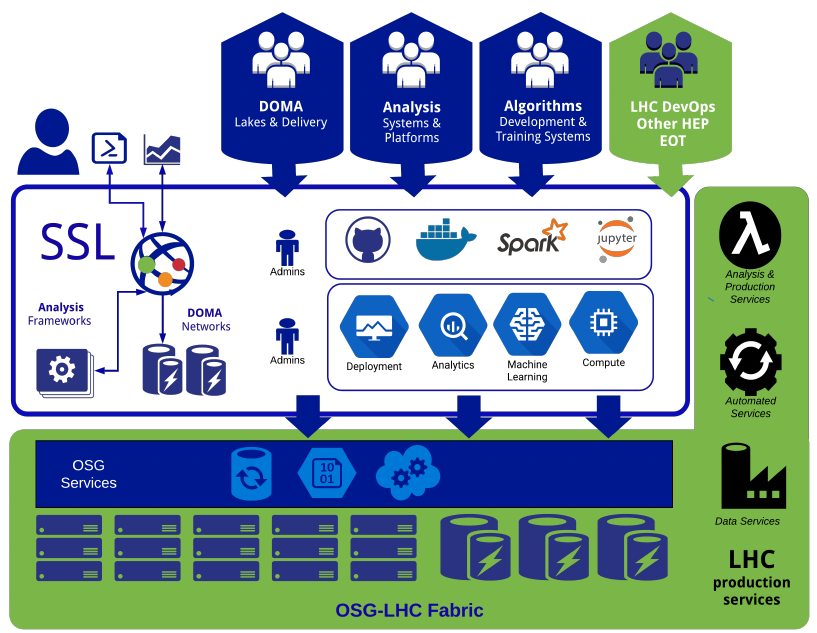
Figure 1: A logical depiction of the IRIS-HEP Scalable Systems Laboratory in relation to the R&D areas of IRIS-HEP, the software and computing teams of the LHC experiments, and the production infrastructure as provided (in this context) by the Open Science Grid (OSG- LHC). The flexible Kubernetes infrastructure of the SSL resulted from an Institute blueprint workshop to understand needs for scalable analysis